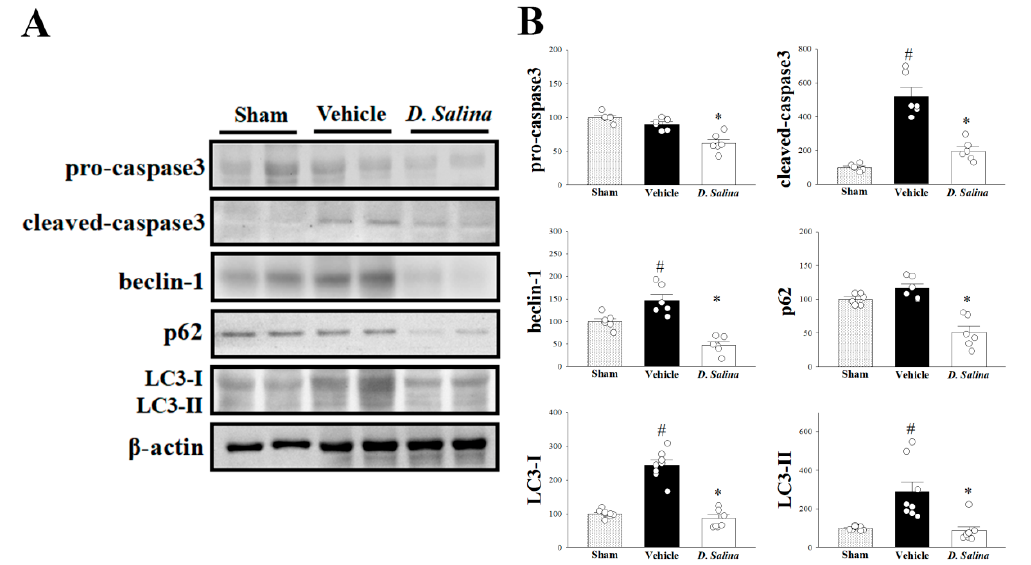
Figure 4. D. salina decreased apoptosis and autophagy after myocardial I/R injury. ( A ) Representative images of the Western blot results in heart tissue. ( B ) Graphs represent the quantitative differences of pro-caspase3 and cleaved-caspase3, beclin-1, p62, LC3-I and LC3-II between sham, vehicle and 1 mg/kg D. salina -treated groups in myocardial I/R animals. β -actin was used as a loading control for the blots. Data are normalized with the mean expression from the sham group. # p < 0.05 compared with the sham group; * p < 0.05 compared with the vehicle group. Values are expressed as mean ± S.E.M. ( n = 6–8).